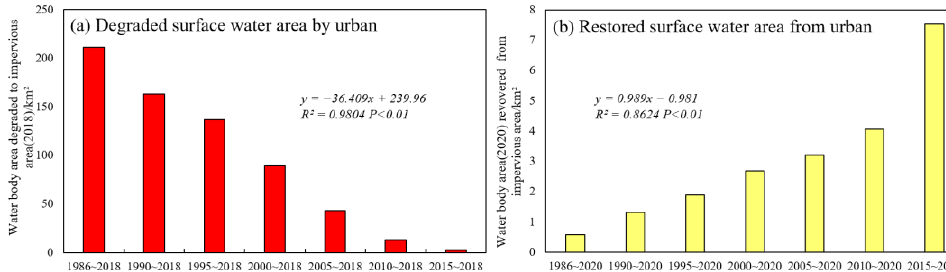
Figure 12. ( a ) The surface waterbody area degraded to impervious land surfaces during seven peri- ods: 1986~2018, 1990~2018, 2000~2018, 2005~2018, 2010~2018 and 2015~2018. ( b ) The surface water- body area restored from impervious land surfaces during seven periods: 1986~2020,